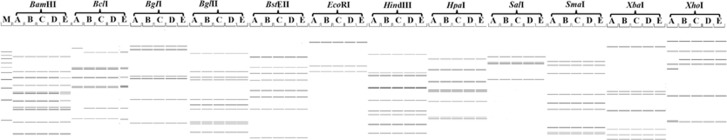
Identification of the genome types of HAdV-B14 strains GZ01 (Guangzhou), BJ430 (Beijing), and CHN2012 (Beijing). The in silico restriction enzyme analysis (REA) digestion patterns of HAdV-14 genomes were generated using the Vector NTI 10.3.0 software (Invitrogen Corp., San Diego, CA, USA). Genome digestion patterns of the strains are as follows: (A) de Wit or prototype (AY803294); (B) GZ01 (JQ824845); (C) 303600, reported as HAdV-B14p1 (FJ822614); (D) BJ430 (JN032132); and (E) CHN2012 (JX892927). These were analyzed with BamHI, BclI, Bgll, BglII, BstEII, EcoRI, HindIII, HpaI, SalI, SmaI, XbaI, and XhoI, as described by Li et al.59 All the three recent China outbreak genomes correspond to the genome type of HAdV-14p1 and have identical REA profiles to each other. They are divergent from the HAdV-B14 prototype (1955). M: 1 kb DNA Sizing Ladder.